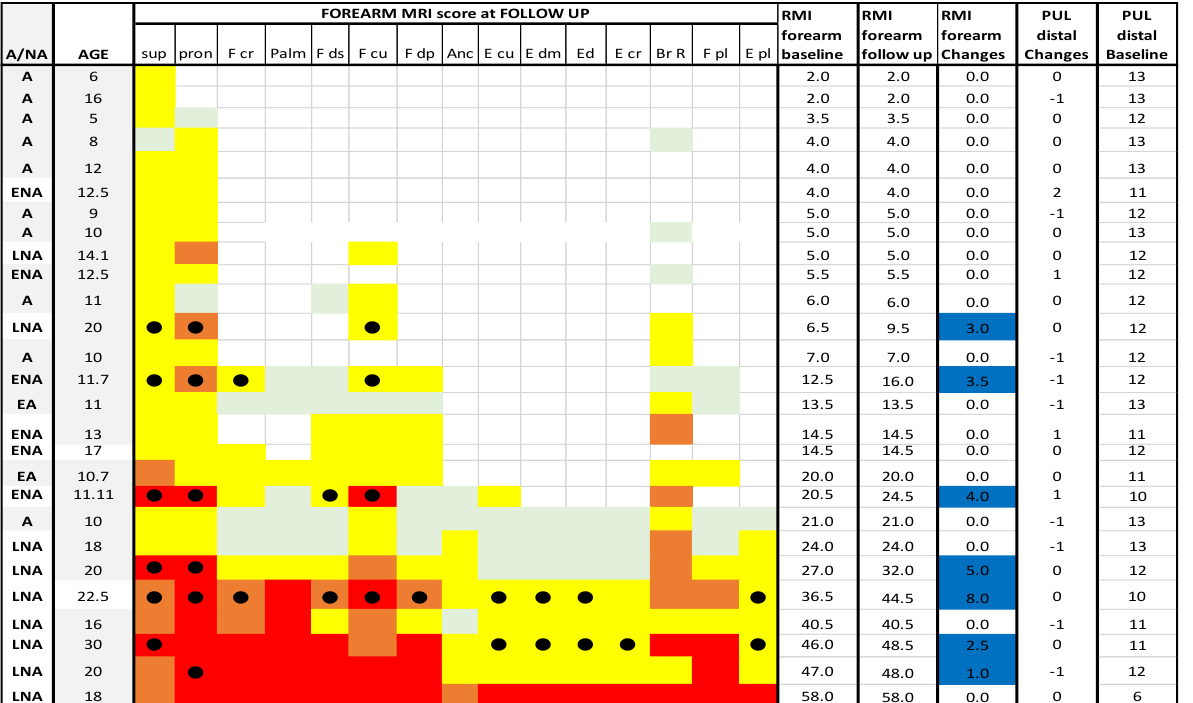
Figure 11. Detail of MRI and PUL at forearm level. Individual details of imaging and PUL findings at forearm level. The shading reflects the severity of involvement with the score of 0 shown as a white cell, score of 1 as pale green, score of 2 as yellow, score of 3 as orange and score of 4 as red. The grade 2.5 was used to identify patients with 2b involvement. Sup = supinator; pron = pronator teres; F cp = flexor carpi radialis; palm = palmar; F ds = flexor digitorum superficialis; F cu = flexor carpi ulnaris; Fdp = flexor digitorum profundus; Anc = anconeus; E cu = extensor carpi ulnaris; Edm = extensor digiti minimi; E d = extensor digitorum; E cr = extensor carpi radialis; Br R = brachioradialis; F pl = flexor pollicis longus; E pl = extensor pollicis longus. A= ambulant; EA = early ambulant; NA= non ambulant; ENA = early non ambulant; LNA: late non ambulant. ● Black circle means a higher Mercuri score respect to the baseline in the respective muscle. Blue line indicates changes in MRI scores.